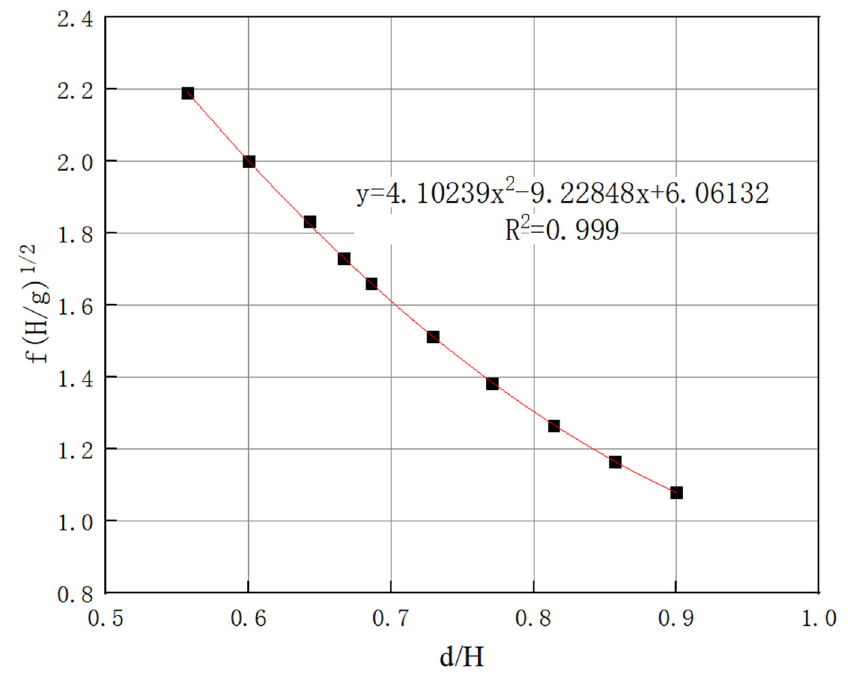
Figure 18. The first spike frequency versus relative water depth. Table 6. Comparison of the numerical solution and correct solution for the relationship between the first peak frequency and water depth.